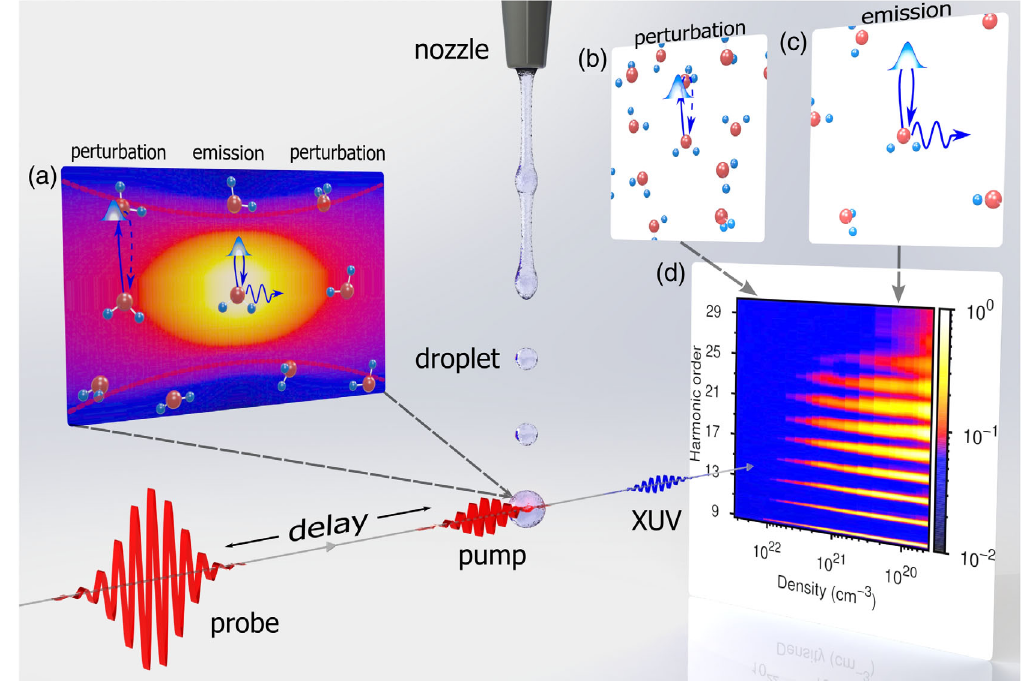
FIG. 2. Schematic illustration of the experimental setup. Two intense, time-delayed laser pulses interact with a liquid droplet in the vacuum. While the first pulse (pump) makes the droplet expand via laser-induced optical breakdown, the second pulse (probe) generates harmonic radiation. Depending on the time delay between the pulses, different densities of the target are accessible for HHG. (a) Different intensities lead to different electronic excursions, such that the electron can be perturbed by surrounding molecules. (b),(c) For a fixed intensity of the probe pulse, this gives access to probe the electronic excursion by increasing the target ’ s density and detecting the harmonic yield. At high densities, the mean interparticle distance of the target ’ s components matches the electronic excursion during HHG, which allows us to induce a perturbation to the quantum paths and (d) results in a decreasing harmonic signal as a function of the